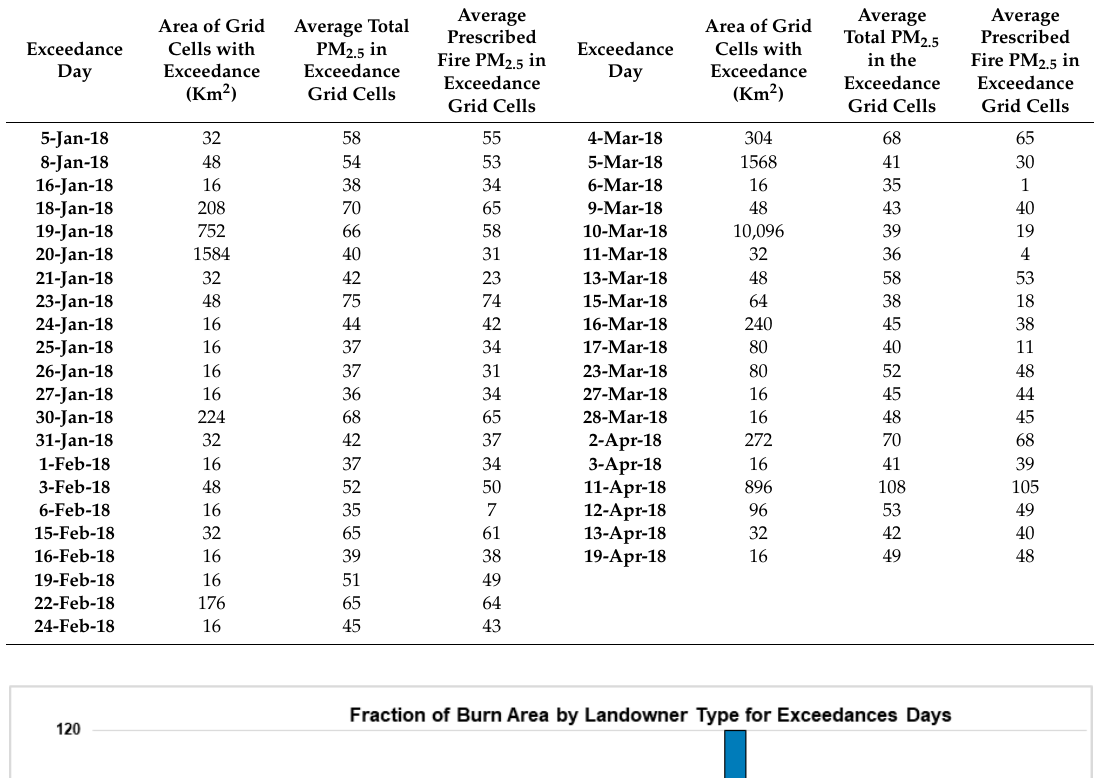
Table 3. Exceedance days along with the number of grid cells and the average particulate matter (PM2.5) concentration.